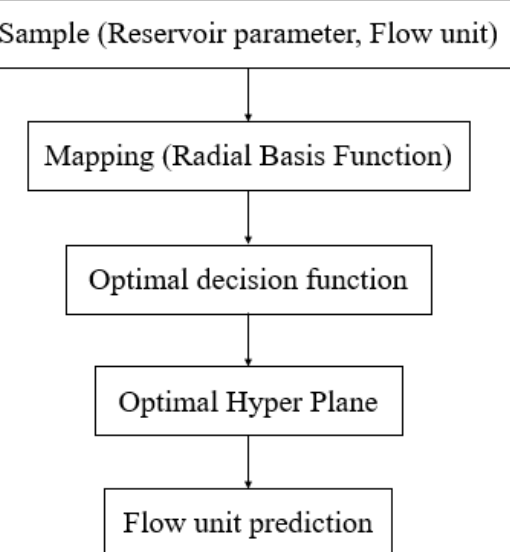
Figure 5. Flowchart of the support vector machine (SVM) method.